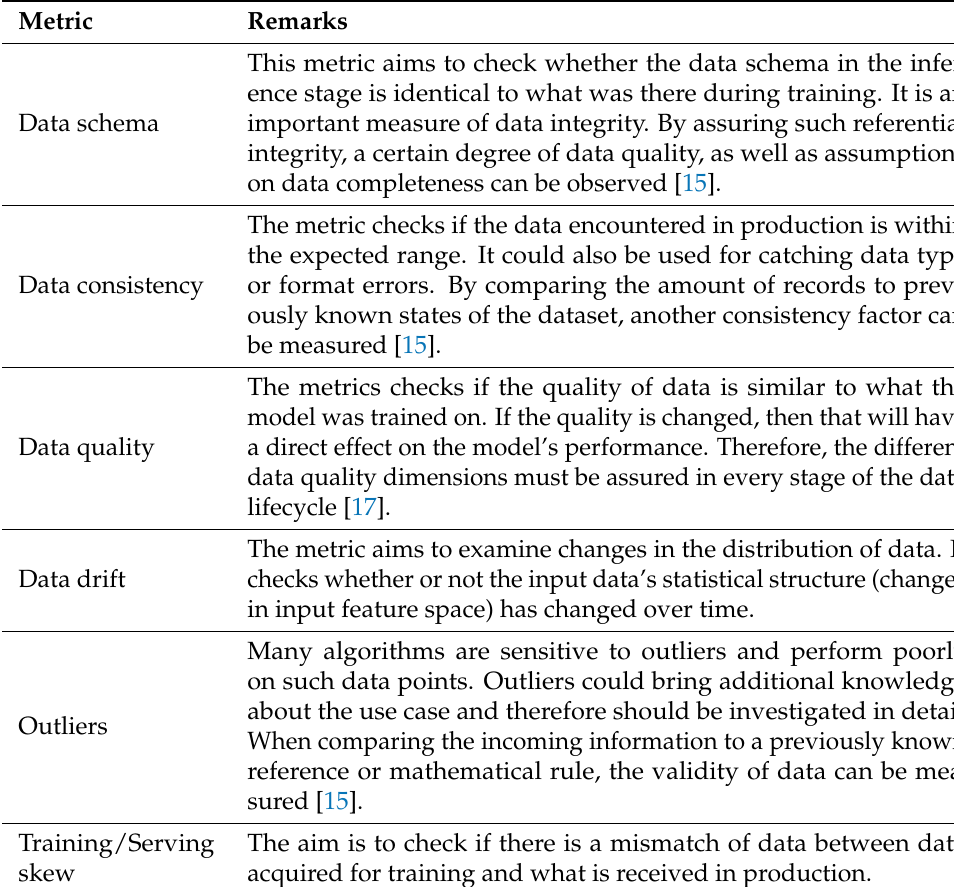
Table 3. Metrics for input data